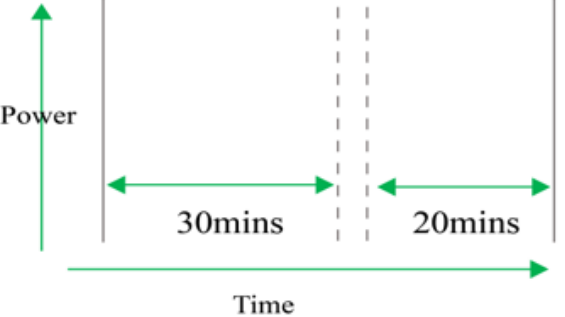
Figure 10. Characteristic hourly charging period.